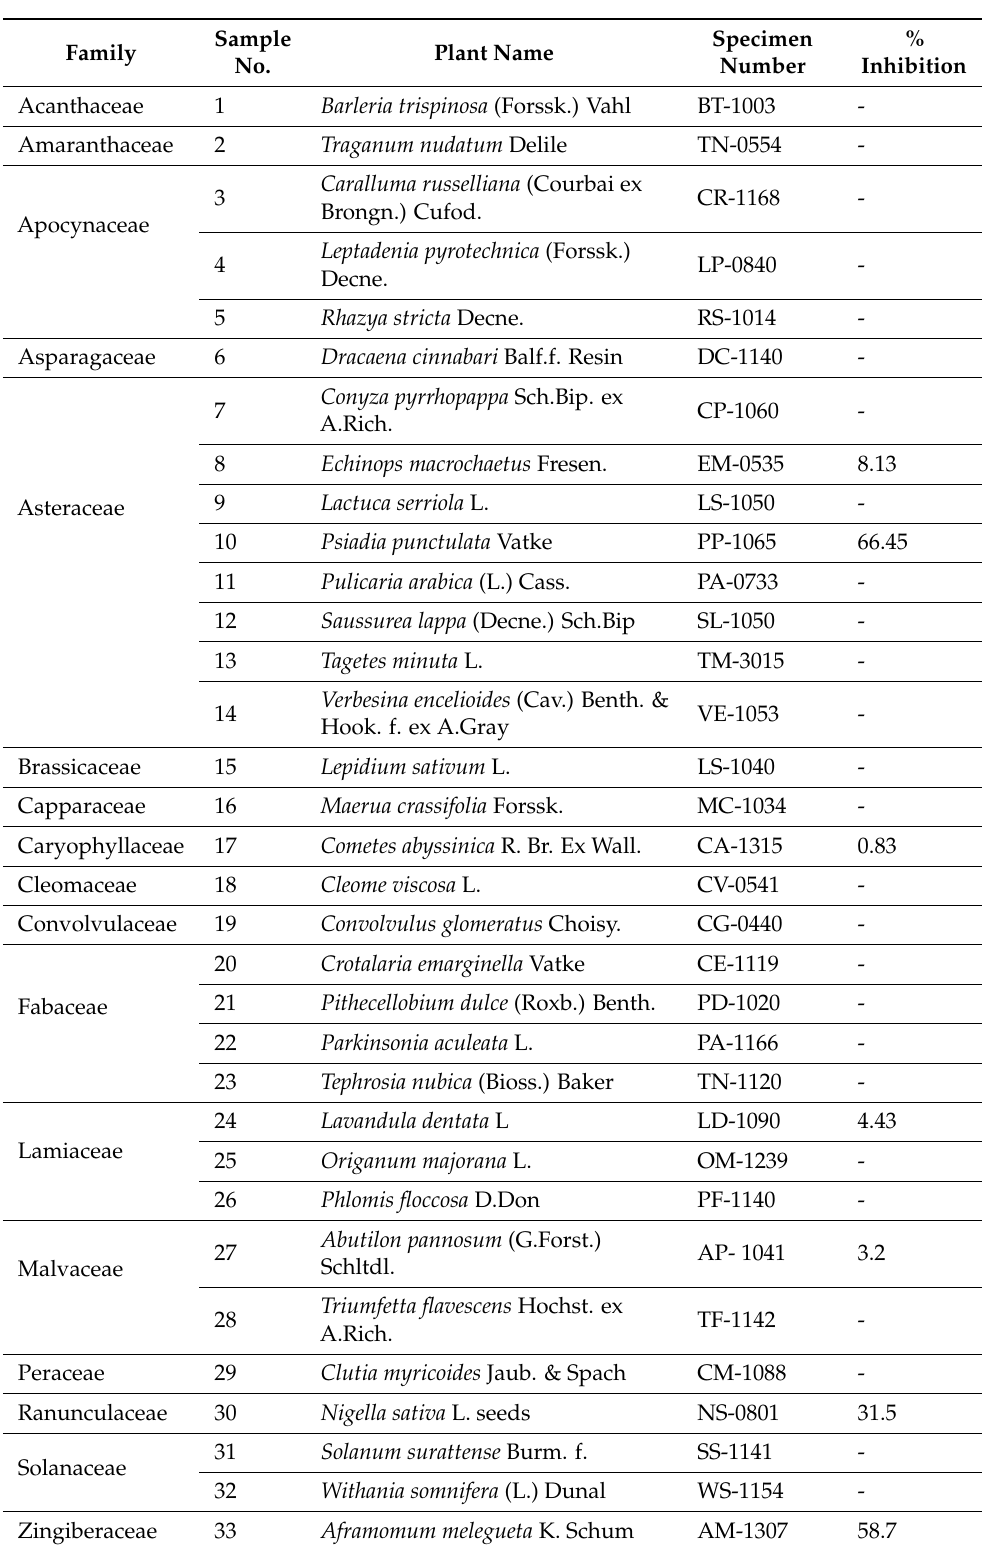
Table 1. Inhibitory activity of the tested plant extracts against SARS-CoV-2 viral main protease (SARS-CoV-2 M PRO